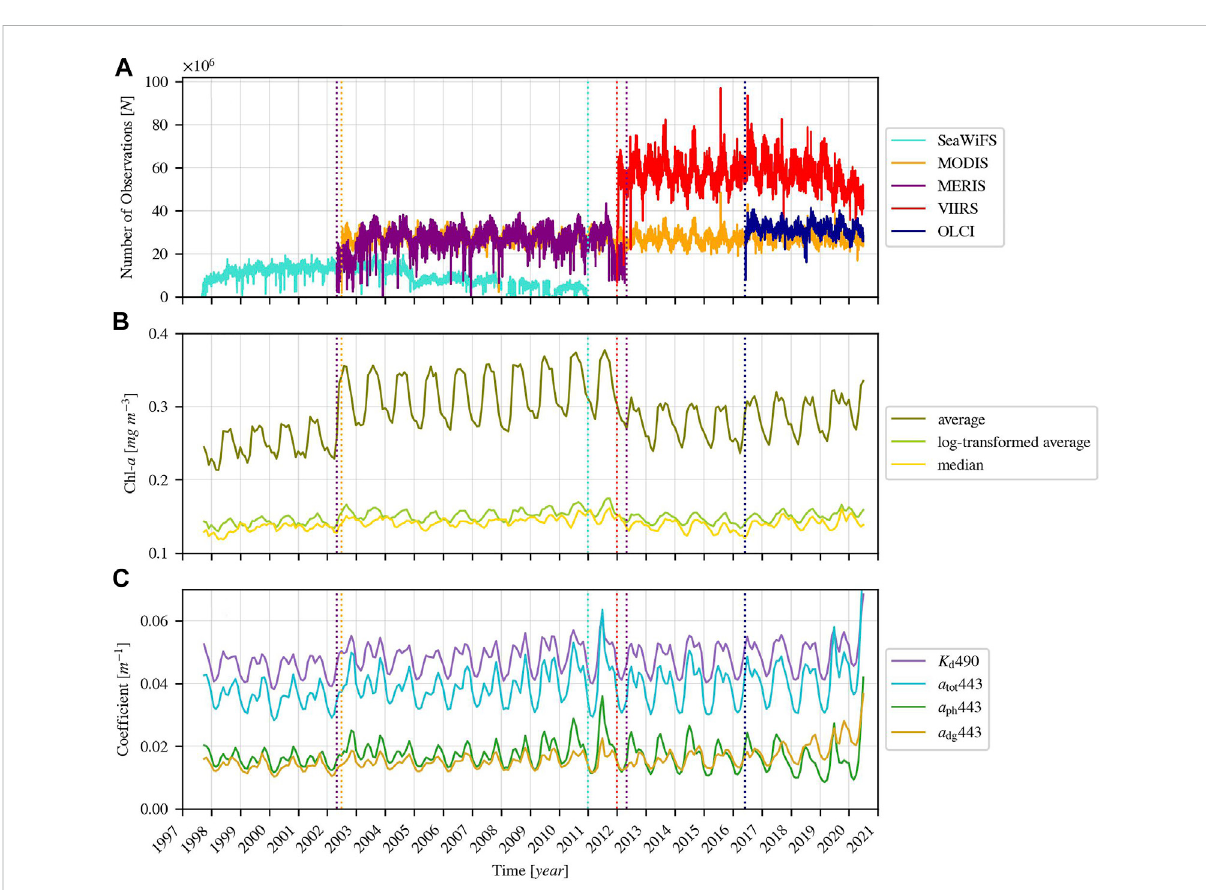
FIGURE 1 TimeseriesofglobalOC-CCIdata: (A) Sumofpixelsdailyobservedbyeachsensor(seelegend),globally (B) Monthly-averagedandmedianChl- a : shown are the original monthly mean, median and “ logarithmically transformed ” mean (see text for details) (C) Monthly-averaged diffuse attenuation coef fi cient at 490 nm, K d 490, and total-, phytoplankton-, and detritus + gelbstoff absorption coef fi cients at 443 nm, a tot , a ph , a dg , respectively (see legend). Vertical lines indicate times when the combination of active sensors has changed (see Table